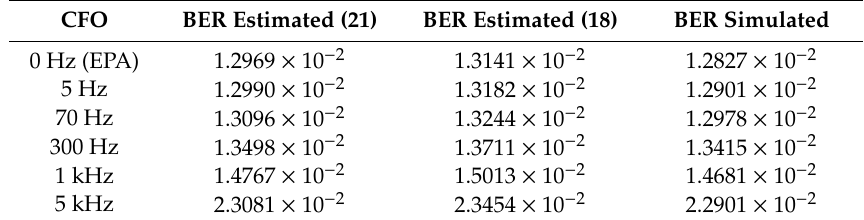
Table 7. Inter-symbol interference (ISI) and (time-dispersion-abstracted) CFO-based BER floor; 16 QAM, EPA